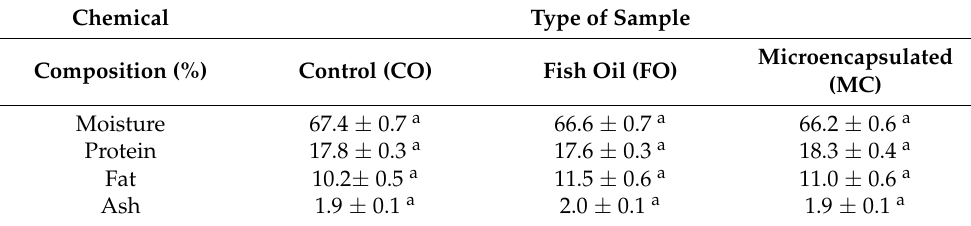
Table 1. The basic chemical composition of the poultry sausages. Chemical Type of Sample Composition (%) Control (CO) Fish Oil (FO)